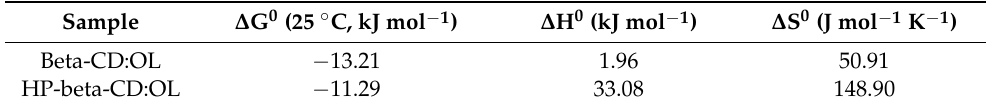
Table 2. Thermodynamic parameters for beta-CD:OL and HP-beta-CD:OL.